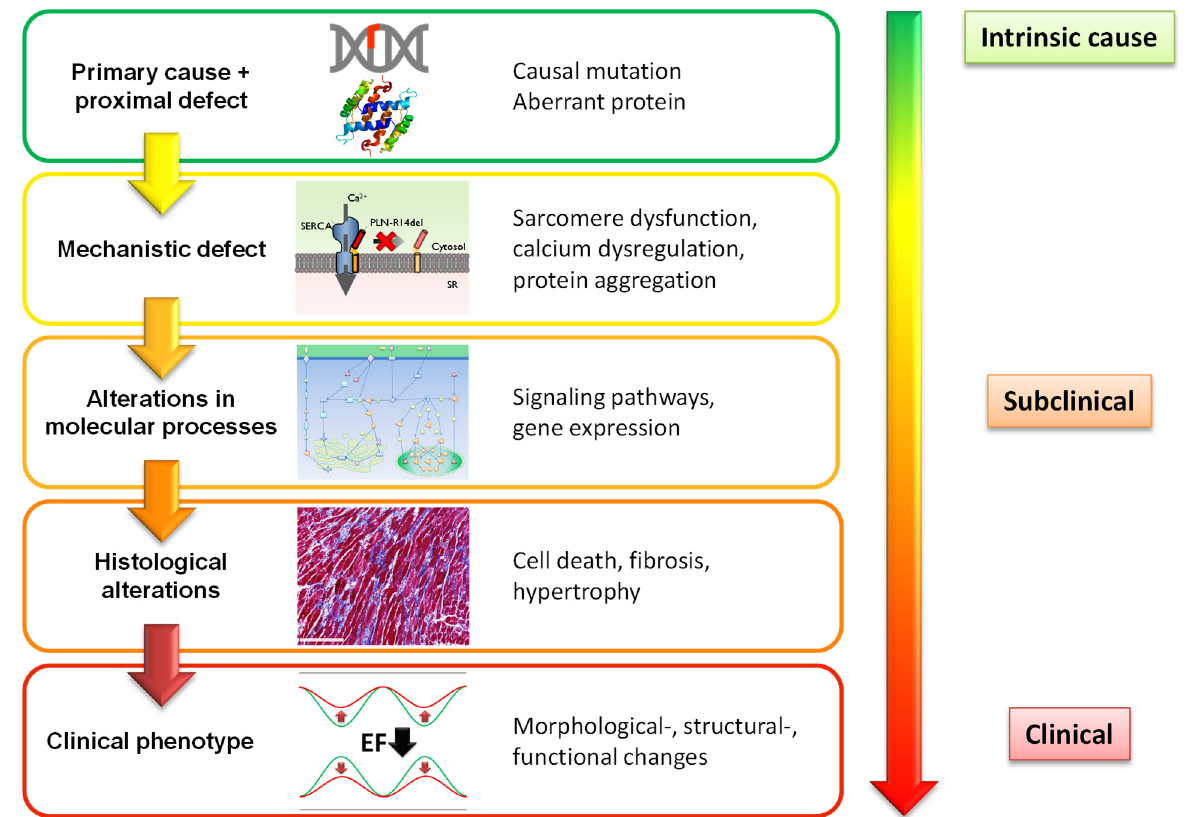
Figure 2. Suggested stages of disease development in genetic cardiomyopathy.